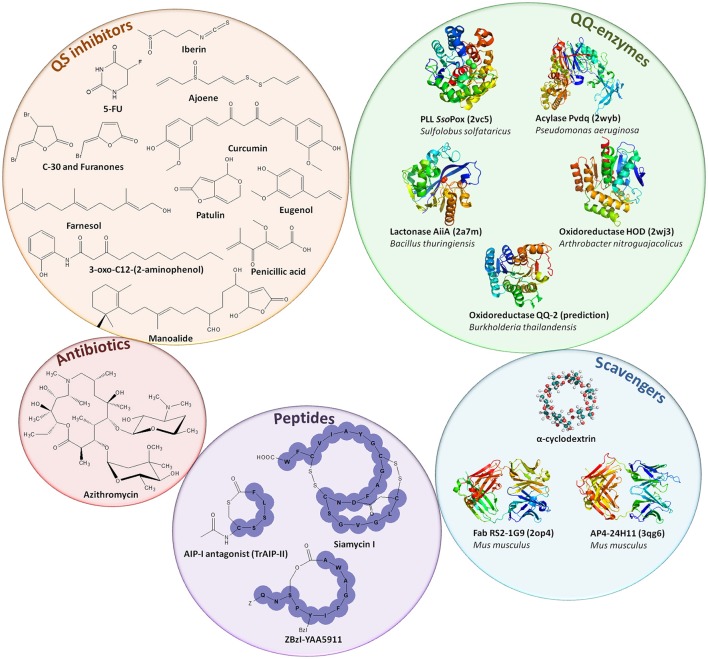
Representation of quorum quenching agents. Quorum sensing inhibitors, mainly acting against AHL or AI-2-based QS, are depicted in the orange circle (Tang and Zhang, 2014). Antibiotics such as azithromycin can be used as QSI at sub-inhibitory concentrations (Swatton et al., 2016). Purple circle represents the QQ peptides used to inhibit Gram-positive QS (Singh et al., 2016). Blue circle represents molecules used to scavenge AIs such as cyclodextrins or derivatives (Morohoshi et al., 2013) and antibodies scavenging AHL (Fab RS2-1G9) or AIP (AP4-24H11) (Park et al., 2007). Green circle depicts QQ enzymes that disrupt AHLs (SsoPox, Pvdq, and AiiA), the quinolone PQS (HOD) and AI-2 signals (QQ-2) (Fetzner, 2015).